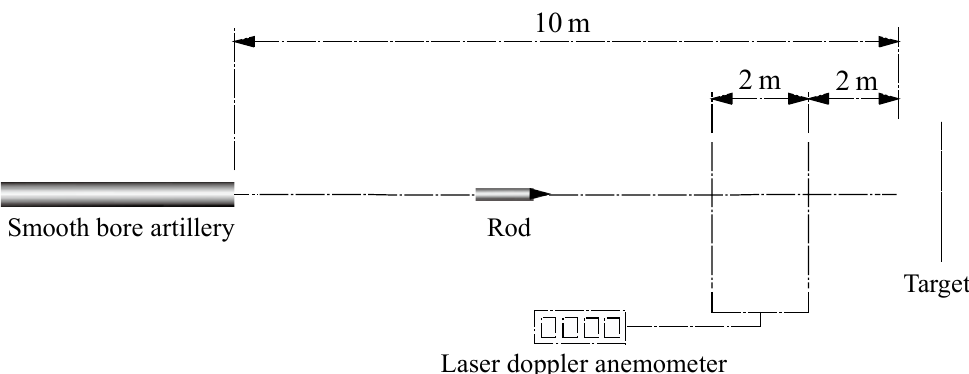
Figure 3. Setup of experiments.